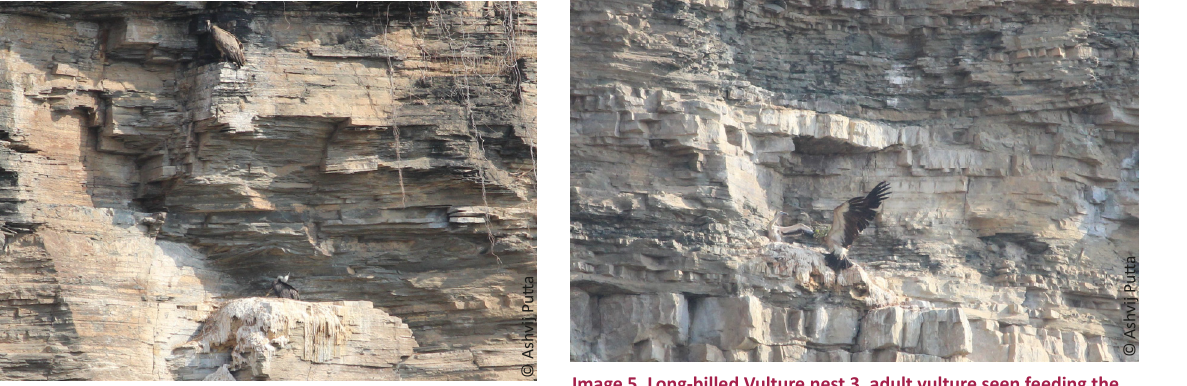
Image 4. Chick (the bird in the lower part of the image) in nest 2.